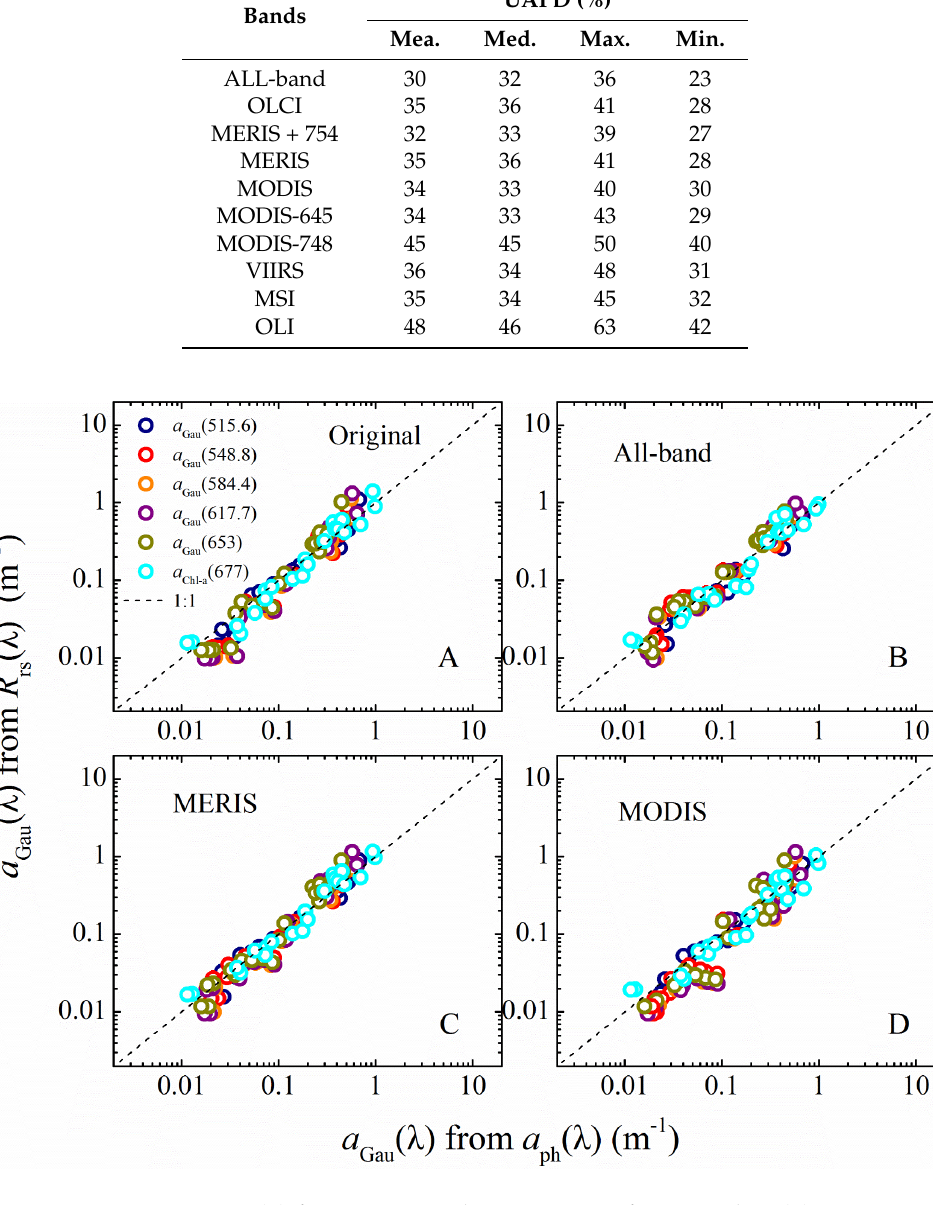
Figure 6. For LE 2014: a Gau ( λ ) from Gaussian decomposition of measured a ph ( λ ) versus a Gau ( λ ) retrieved from: R rs ( λ ) with original hyperspectral bands ( A ); the combined all sensor bands ( B ); MERIS bands ( C ); and MODIS bands ( D